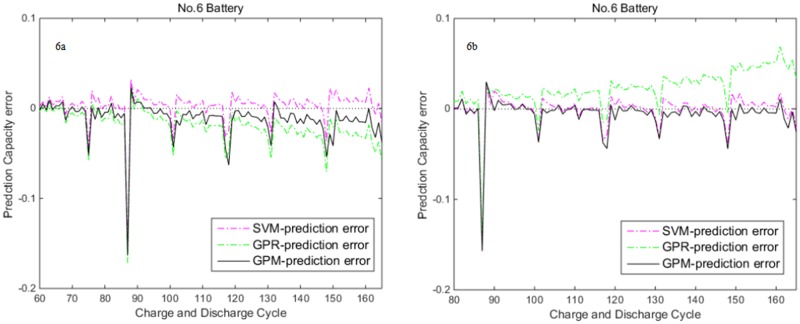
Prediction error curve of No.6 battery with different starting points by three models.(a) the 60th cycle as the starting point. (b) the 80th cycle as the starting point.